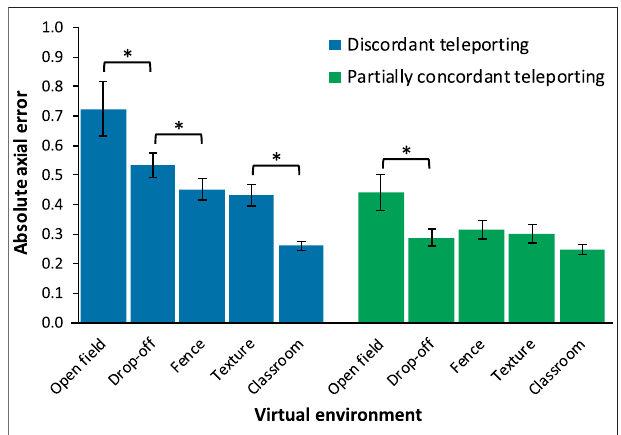
FIGURE 4 | Mean untransformed absolute axial error shown separately by condition. Higher values correspond to greater error (i.e., worse performance). Error bars represent +/ − 1 SEM. Asterisks represent signi fi cant differences using repeated contrasts. Note that not all possible pairs were tested, see Section 3.2 for